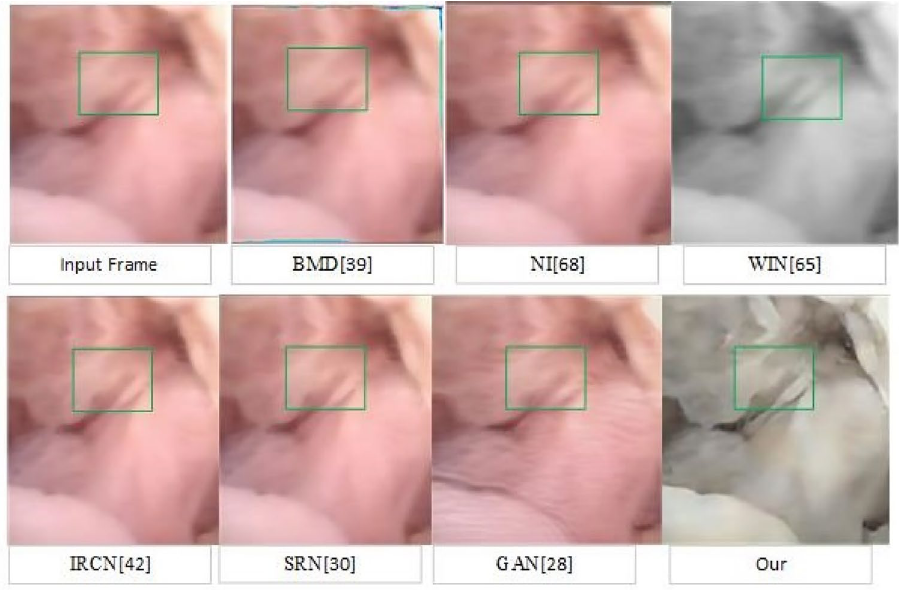
Figure 4. Visual comparison of the deblurred frame obtained from traditional, deep learning, and our method. As one can see, our method retrieved sharp texture and white balanced frame.